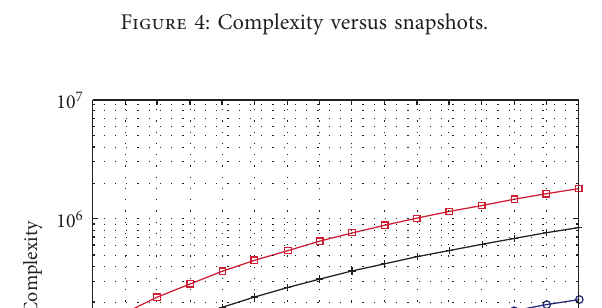
Figure 6: RMSE of three PM algorithms versus SNR.